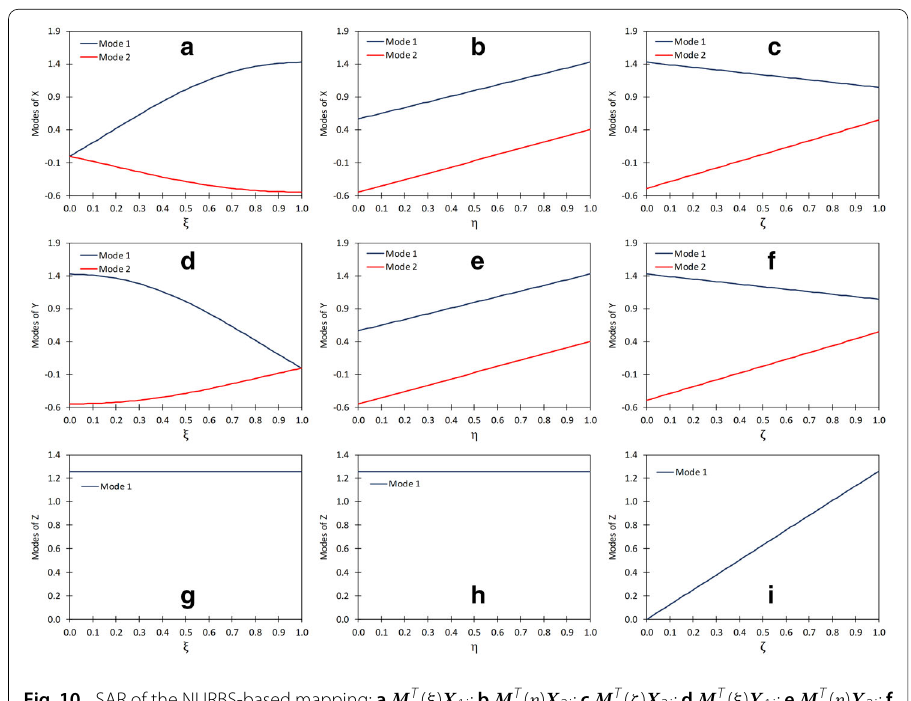
( ξ ) X 1 i ; b M T 1